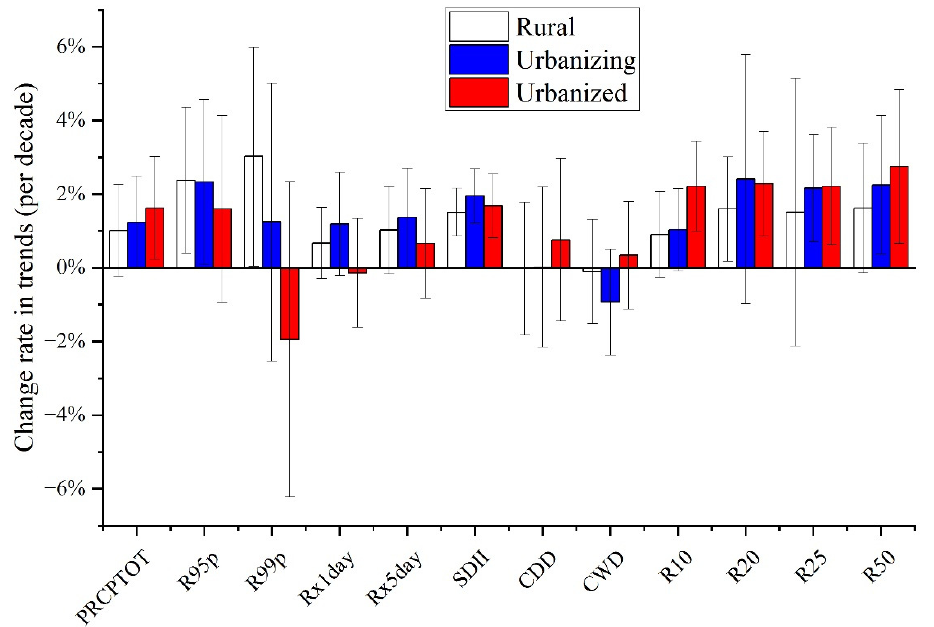
Figure 10. Error bars for the scaling trends of precipitation extremes over the PRD during 1961–2017 (unit: % per decade).